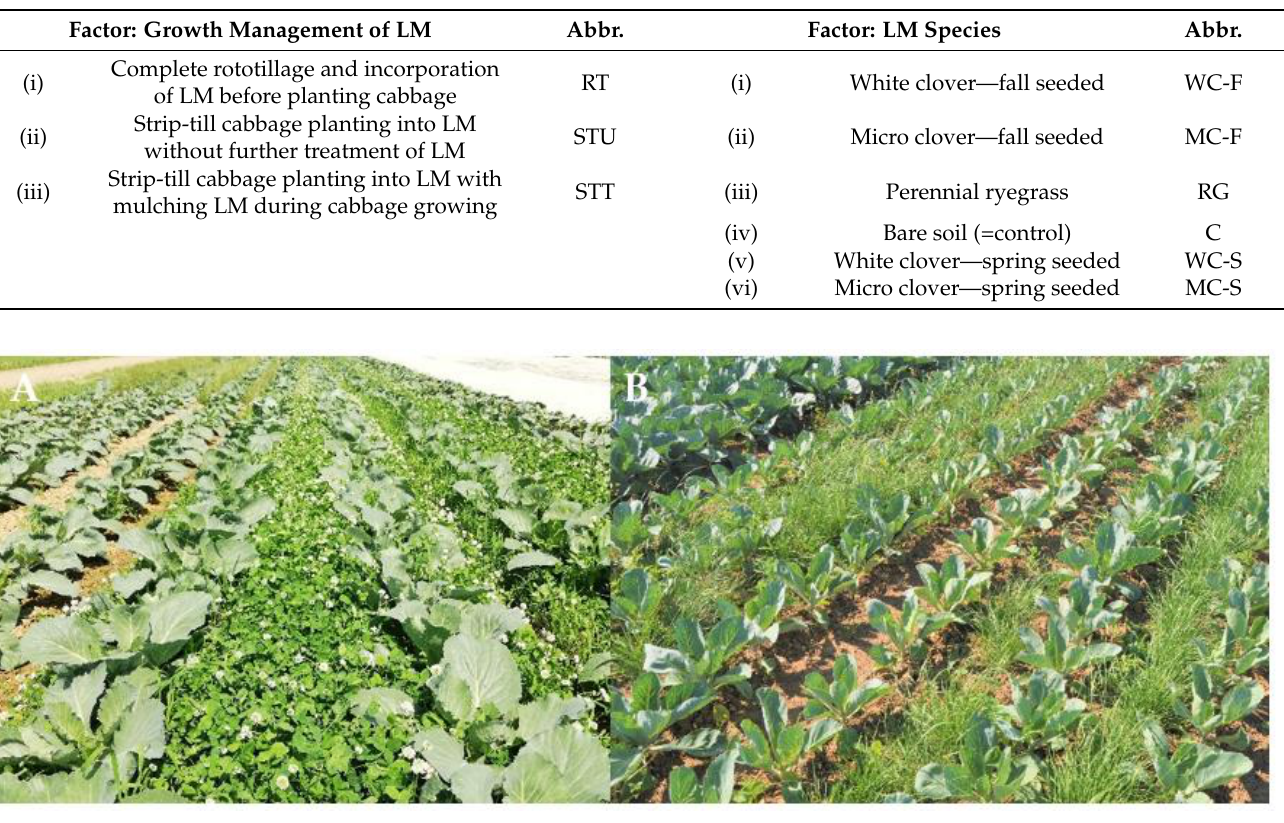
Figure 2. Established clover – cabbage ( A ) and ryegrass – cabbage ( B ) intercropping.